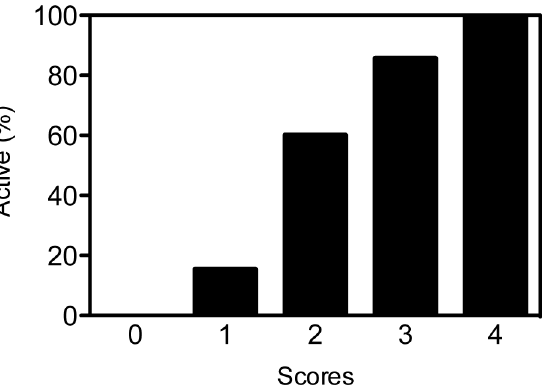
Fig 3. Rates of identification of active TB on the basis of the total score for combination of four cytokines (IL-10, IFN- γ , MCP-1 and IL-1RA) in TBAg – Nil supernatant.